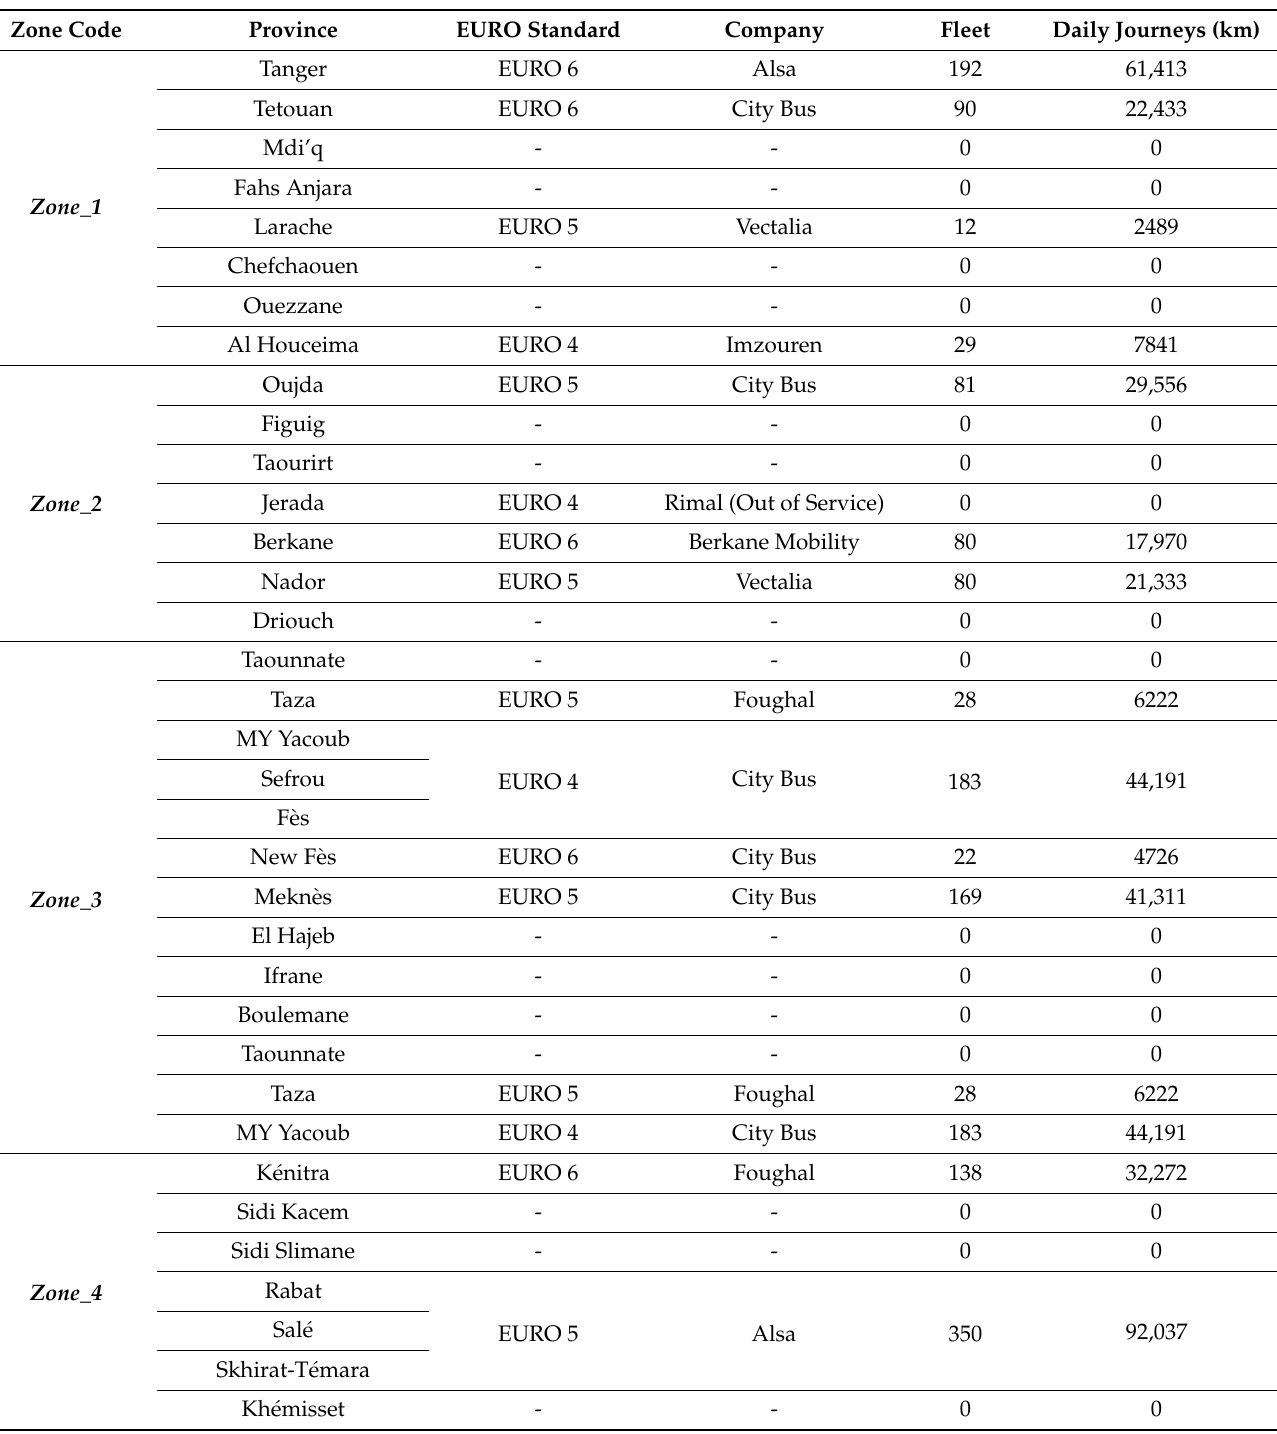
Table 2. Public Bus Fleets Data in Morocco by